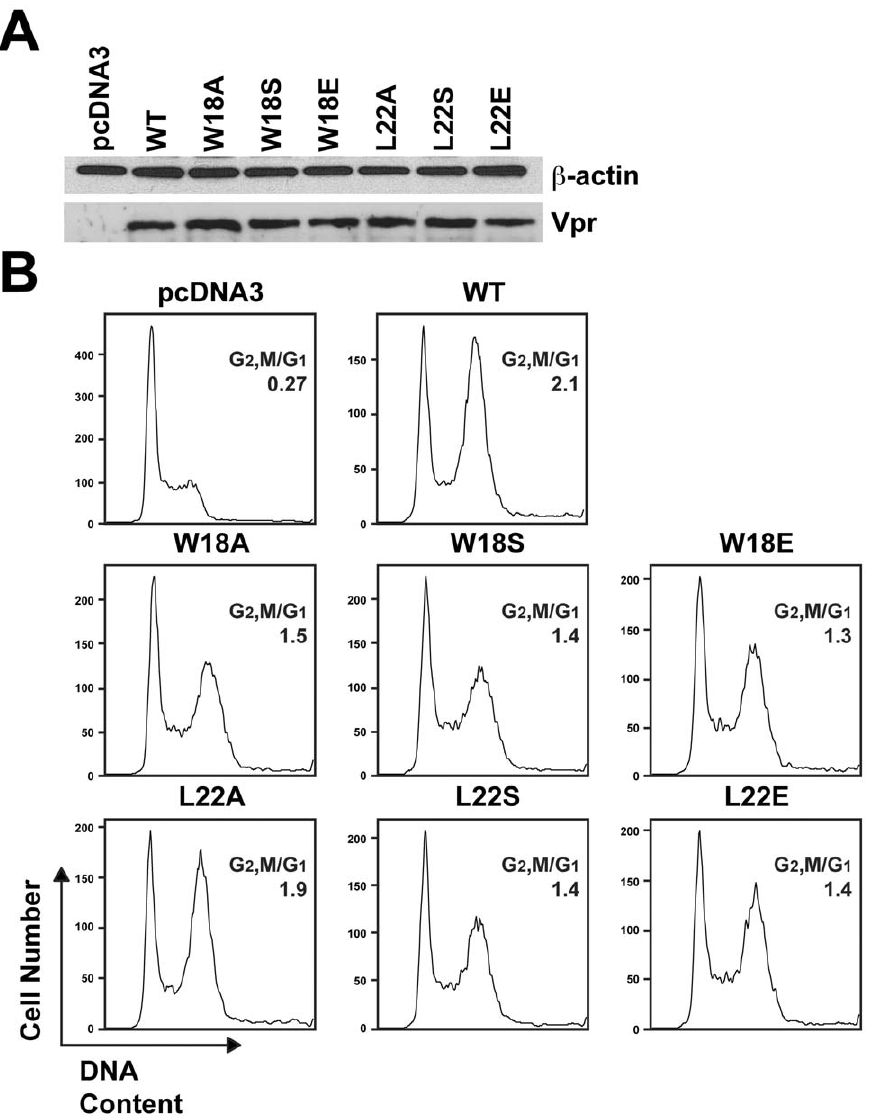
Figure 4. Exposed hydrophobic residues on Vpr helix-1 are important for transfected Vpr G2/M arrest. Jurkat cells were co-transfected with pcDNA3-hVpr plasmids expressing WT or mutant Vpr (or the empty vector control) and pEGFP-N1 as a transfection marker at a ratio of 5:1. ( A ) Western blot of the Jurkat cells for WT or mutant Vpr (bottom). A western blot of b -actin was used as a protein loading control (top). ( B ) Histograms of cell cycle analysis at 61 hr post-transfection show DNA content of GFP + , PI-stained cells by flow cytometry. All samples represent 10,000 cellular events. G1 and G2/M populations were modeled using the Watson Pragmatic cell cycle model, and the G2,M/G1 ratio in each transfection is shown. The data are representative of three experiments.